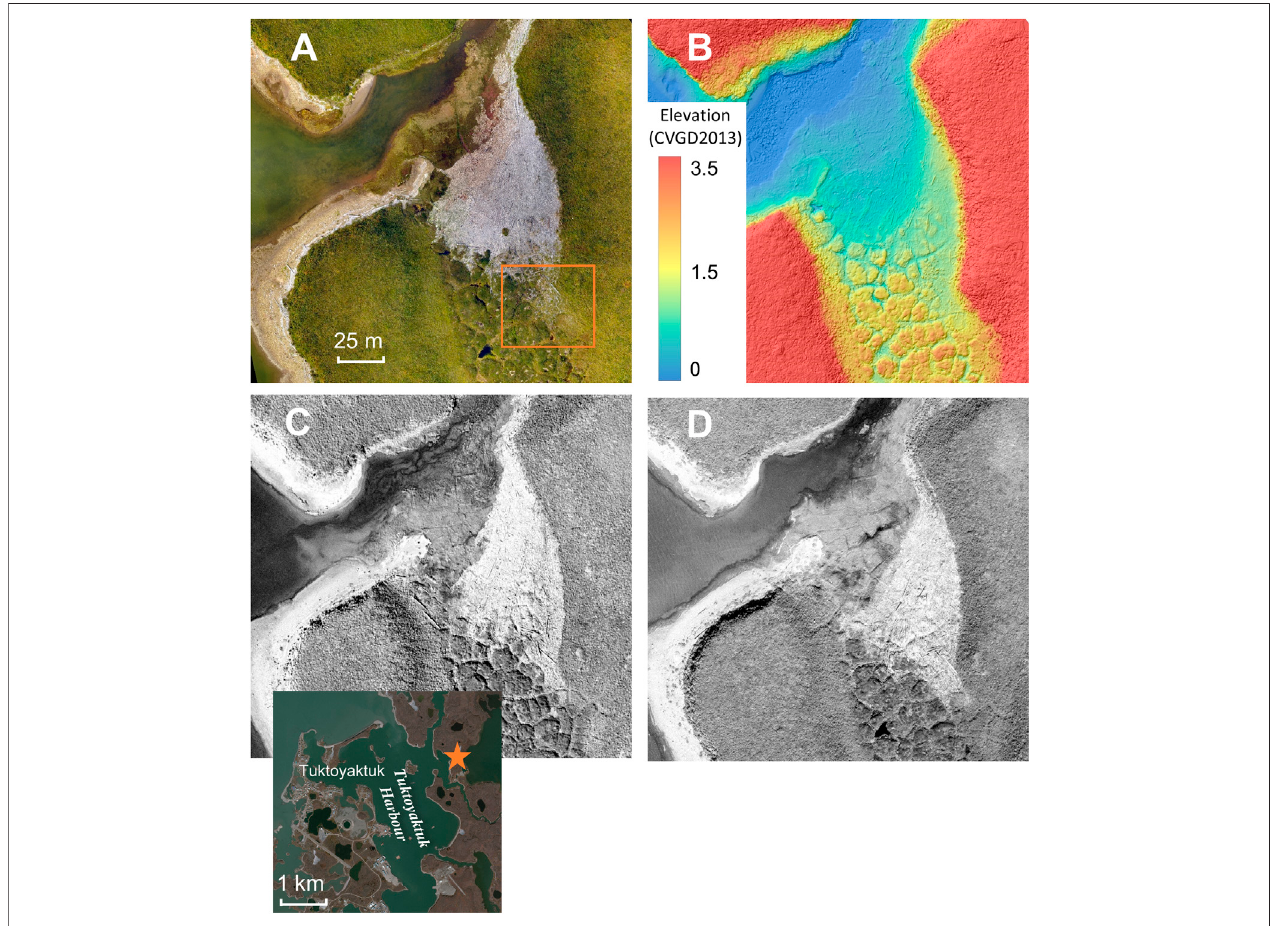
FIGURE 4 | Examples of typical datasets used for analyses at driftwood study sites. Figures (A,B) were derived from 2018 drone surveys and SfM processing for the Tuktoyaktuk Harbor site. Figure A is an orthophoto and B is a Digital Surface Model (DSM). The color scale in elevation values in the DSM image range from 0 m (CGVD2013) in blue to3.0 m inred. Forcomparison,panchromatic air photos from 1968 to1972 (C,D) respectively areshown. The orange box in Adisplays the extent of Figure 5 . The inset map in the bottom left corner shows the location of this driftwood accumulation in relationship to the Tuktoyaktuk harbor.